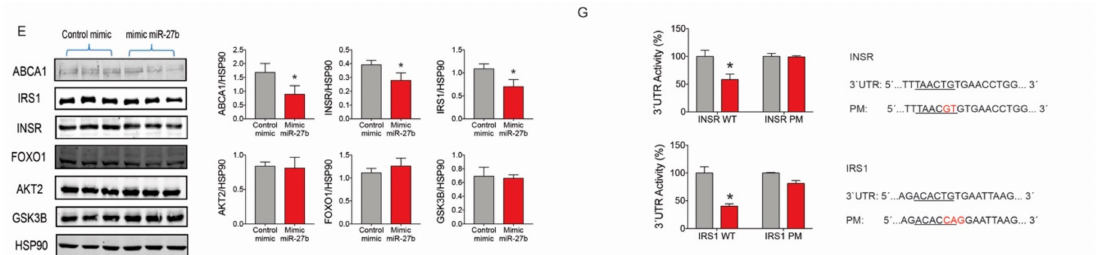
Figure 2. miR-27b modulation a ff ects insulin signaling in Huh7 cell line: ( A , B ) miR-27b levels in Huh7 cells transfected with ( A ) 40 nM control mimic and mimic miR-27b or ( B ) 40 nM control inhibitor and inhibitor miR-27b; ( C , D ) mRNA expression of ABCA1 , INSR , IRS1 , AKT2 , FOXO1 and GSK3 β in Huh7 cells transfected with ( C ) 40 nM control mimic and mimic miR-27b or ( D ) 40 nM control inhibitor and inhibitor miR-27b; ( E ) Western blot analysis of ABCA1, INSR, IRS1, AKT2, FOXO1 and GSK3 β expression in Huh7 cell transfected with miR-27b mimic or miR-27b inhibitor and their respective controls; ( F ) Western blot analysis of ABCA1, INSR, IRS1, AKT2, FOXO1 and GSK3 β expression in Huh7 cell transfected with miR-27b mimic or miR-27b inhibitor and their respective controls; and ( G ) analysis of miR-27b targeting on the 3 (cid:48) UTR of human INSR and IRS1 by luciferase reporter assay. * p < 0.05 (significantly di ff erent from cells transfected with the CM or CI). Data are presented as the mean n = 3 independent experiments ((A–D,G and right-handed panels of (E,F)). Data correspond to results from a representative experiment among three that gave similar results in left-handed panels of (E,F).